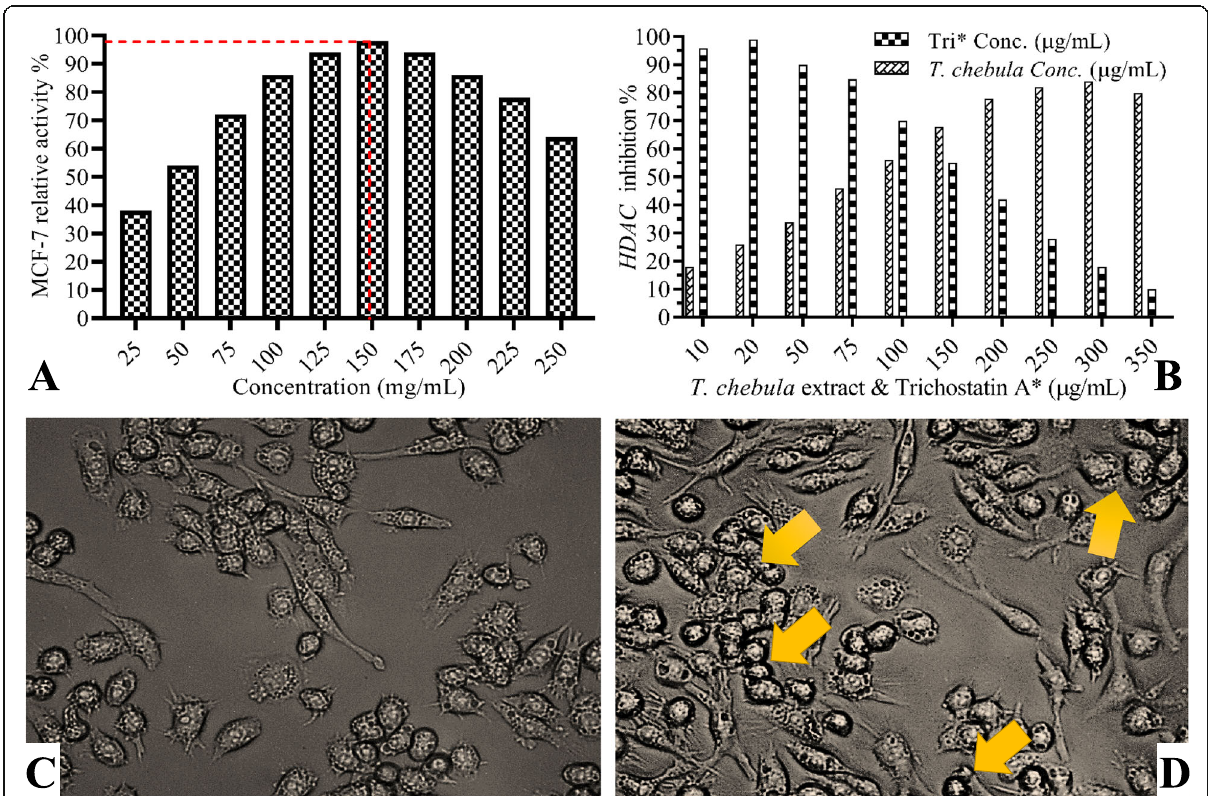
Fig. 7 Effect of ethanolic extract of T. chebula on HDAC inhibition and anti-proliferation on MCF-7 cell line. a Relative activity % of ethanolic extract of T. chebula (effective at 150 mg/mL). b HDAC inhibition results of Trichostatin A and ethanolic extract of T. chebula . c and d Effect of treatment of ethanolic extract of T. chebula on